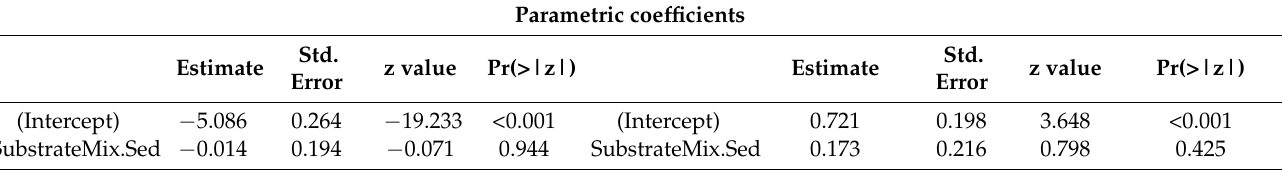
SubstrateMix.Sed −